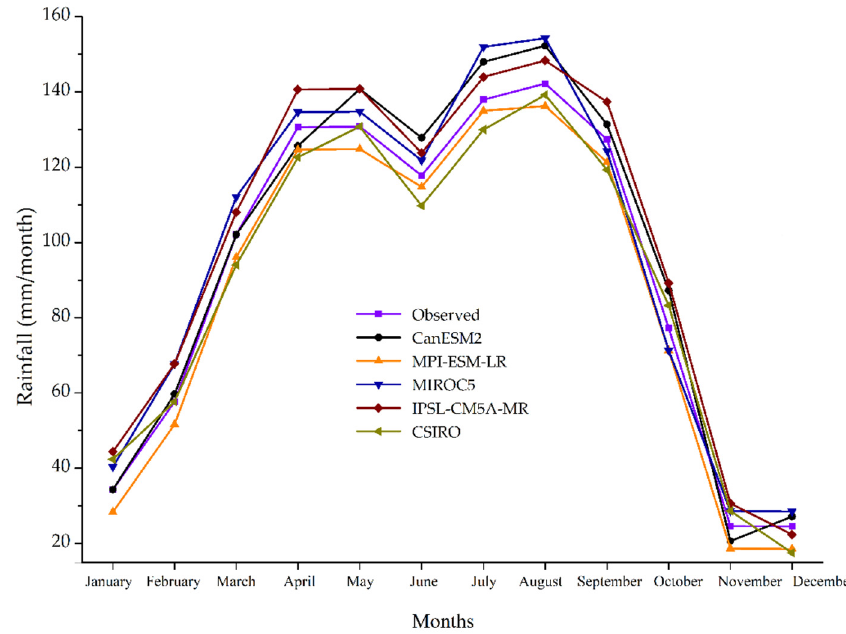
Figure 7. Observed monthly rainfall and GCM simulated baseline rainfall (1986–2005).